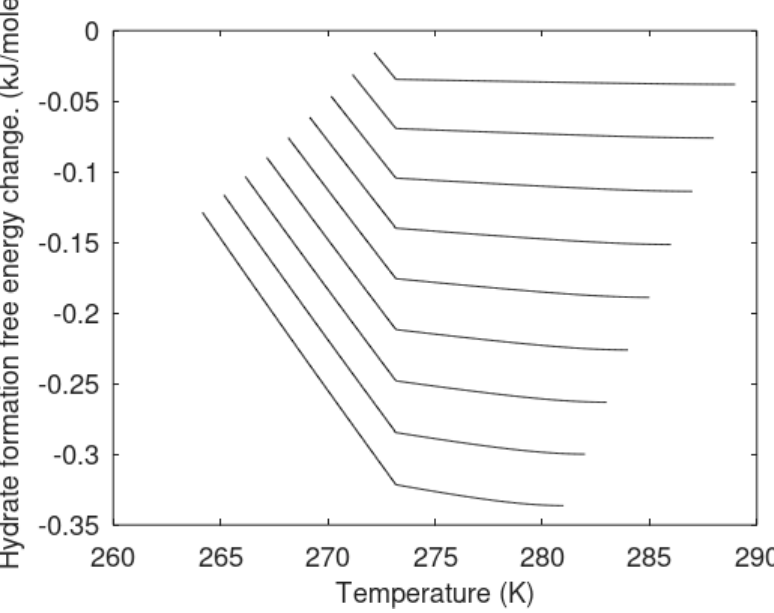
Figure 14. The Gibbs free energy change for heterogeneous hydrate formation as function of various degrees of sub-cooling. Sub-cooling is calculated for every pressure along the pressure/temperature hydrate stability limits in Figure 1. Upper curve is for 1 °C sub-cooling, then 2 °C sub-cooling, then 3 °C sub-cooling, then 4 °C sub-cooling, then 5 °C sub-cooling, then 6 °C sub-cooling, then 7 °C sub-cooling, then 8 °C sub-cooling and lowest curve for 9 °C sub-cooling.